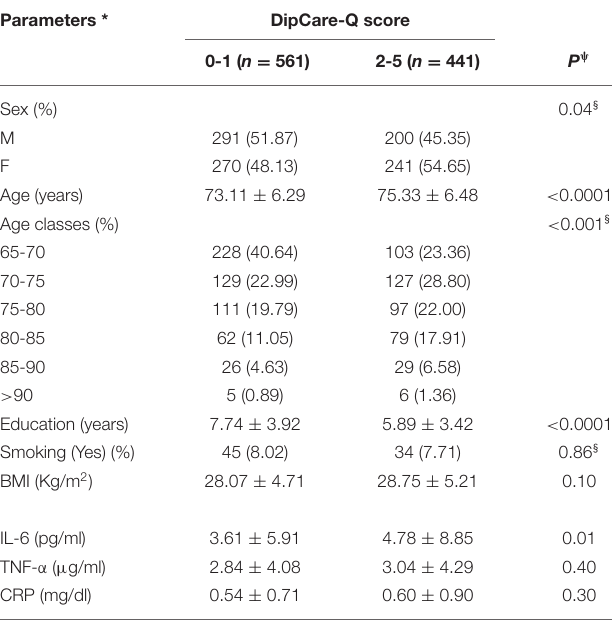
TABLE 2 | Food groups average consumption (expressed in grams) categorized according to the Deprivation in the Primary Care Questionnaire (DiPCare-Q) score.